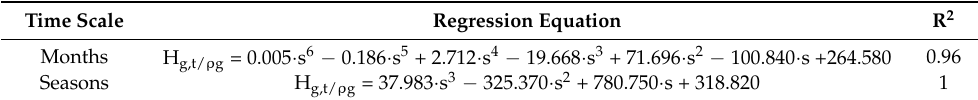
Figure 6. Intra-annual variation of H g,t/ ρ g under all-sky conditions, averaged over all sites and over each month in the period 2005–2016. The black solid line represents the average monthly H g,t/ ρ g sums. The red line corresponds to the mean + 1 σ curve, and the blue line to the mean − 1 σ one. The green dotted line refers to the best-fit curve to the mean one. Table 3. Regression equations for the best-fit curves to the monthly (seasonal) mean H g,t, β / ρ g sums averaged over all 82 sites in the period 2005–2016, together with their R 2 values; s is month in the range 1–12; 1 = January, . . . ,12 = December (season in the range 1–4; 1 = spring, 2 = summer, 3 = autumn, 4 =